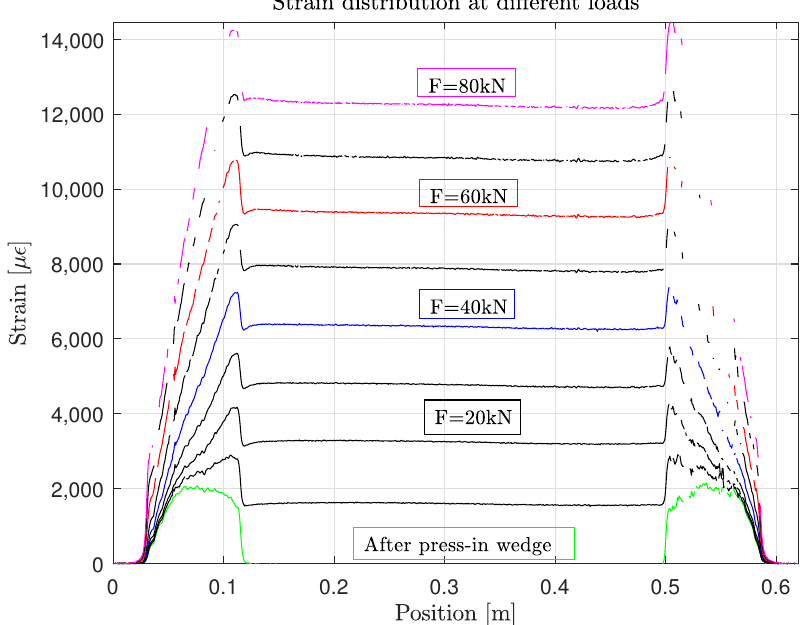
Figure 13. Strain distribution of the tendon at discrete load steps of 10 kN.